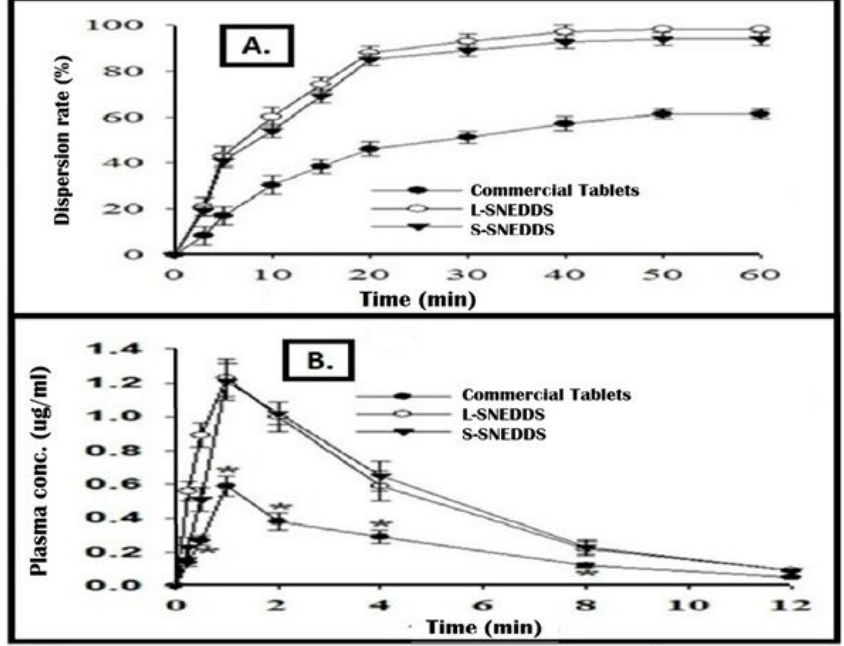
Figure 10. ( A ) In vitro dispersion profiles of S-SNEDDS tablets, L-SNEDDS and Genesis ® commercial tablets and ( B ) In vivo plasma drug concentrations at different time intervals. Each value represents the mean ± SD (n = 6).